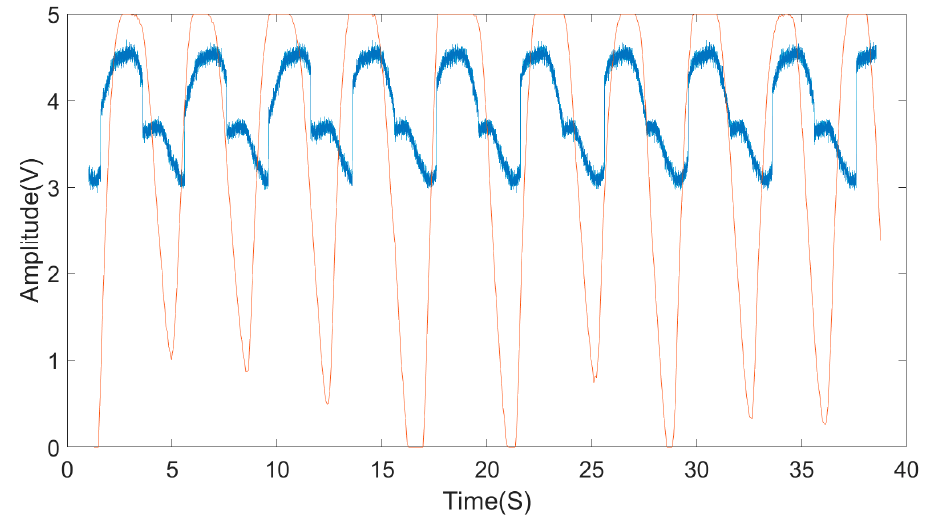
Figure 15. The output with a directional antenna compared with a polyvinylidene fluoride (PVDF) system, in which the red line is the output of the PVDF system.